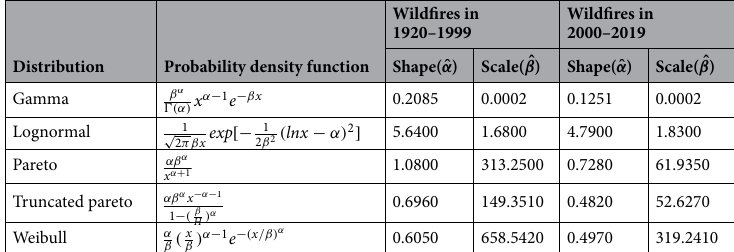
Table 1. Heavy-tailed distribution fitting results of wildfire size distribution.